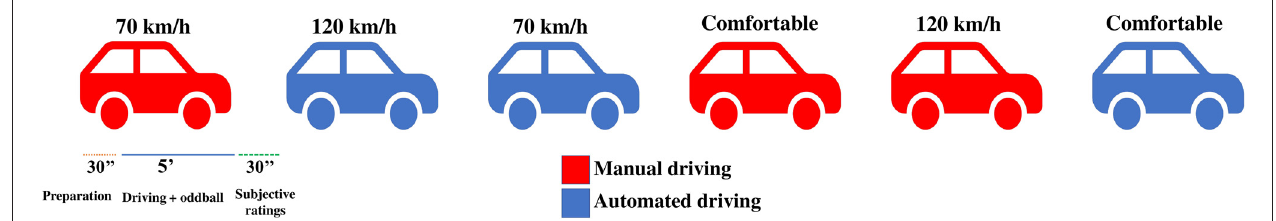
FIGURE 2 | An example of a sequence of conditions in the experiment. The actual order was randomized for each participant. Each condition consisted of 30 s of just driving (preparation), followed by 5 min of driving and oddball performance. Subjective ratings of mental demand and vigilance were performed right